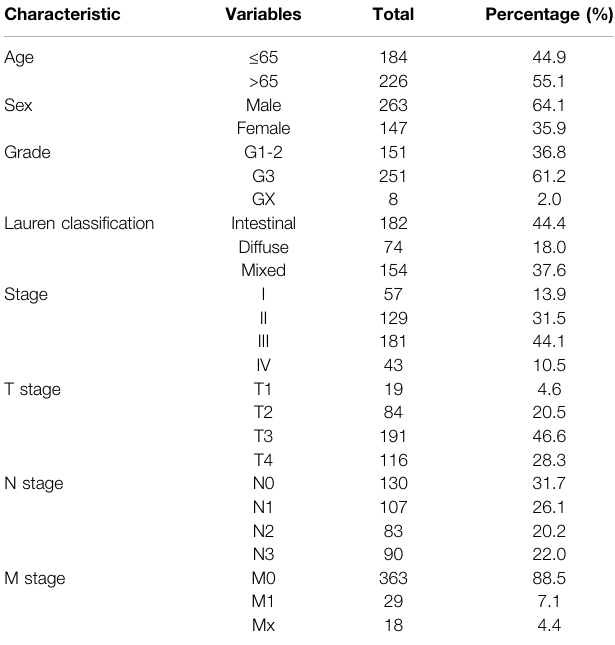
TABLE 1 | Clinical characteristics of GC patients with chemotherapy in TCGA cohort. Characteristic